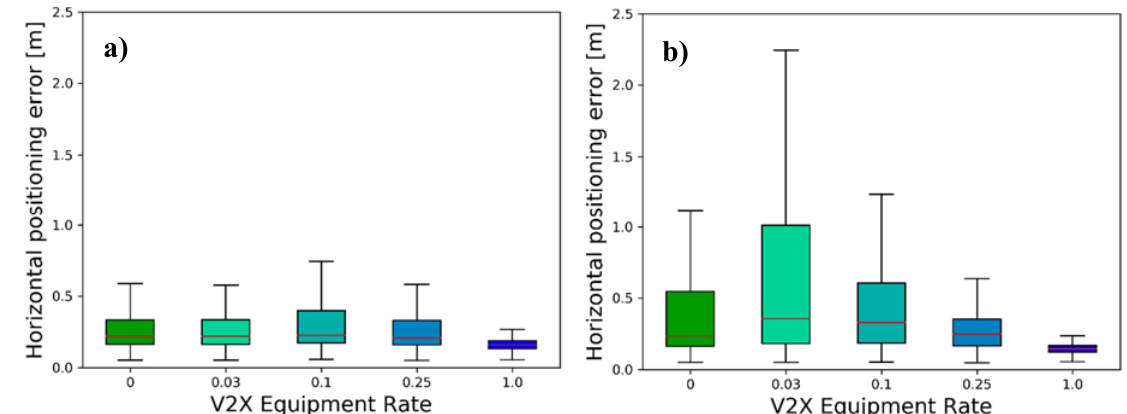
Figure 13. Object Tracking Accuracy for ( a ) the low traffic scenario and ( b ) the high traffic scenario in dependence of the V2X equipment rate aggregated for the objects within the security range, showing typical data range (whiskers), interquartile range (boxes) and median (red-colored